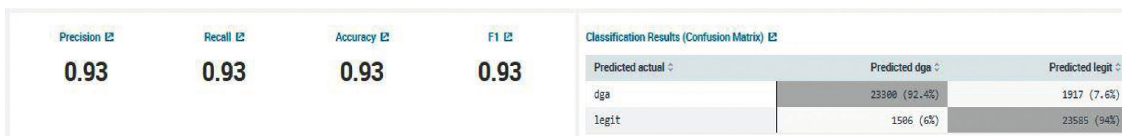
Figure 12: Results of evaluating values based on the decision tree algorithm without using the principal component analysis feature.